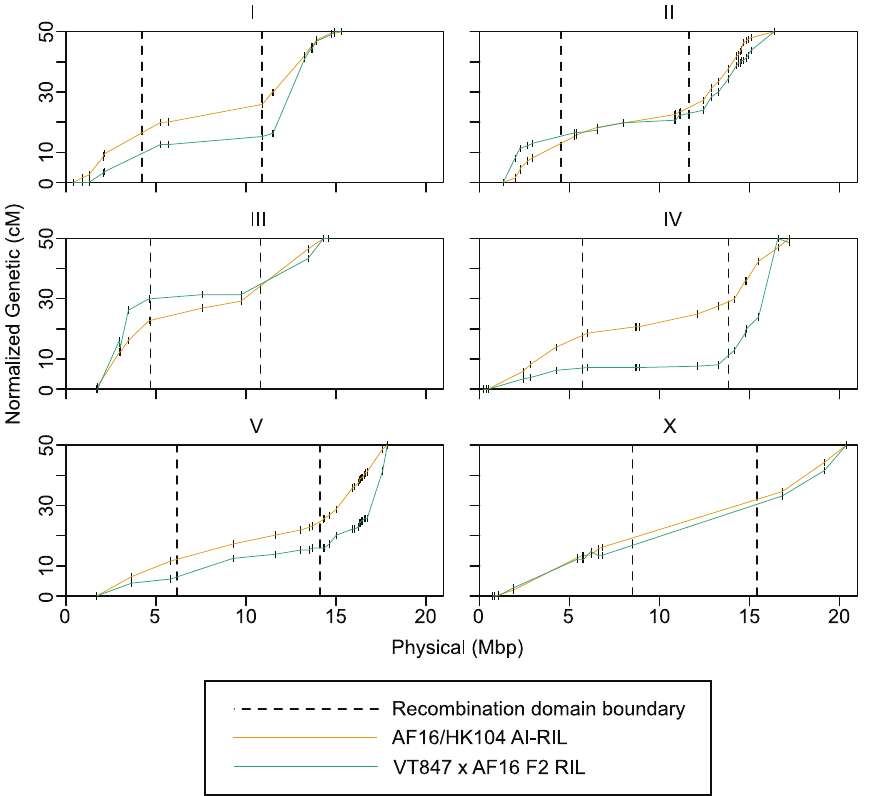
Figure 4. Intra-species recombination rate comparison. The Marey maps for the AF16/HK104 AI-RIL and the VT847 6 AF16 F2 RIL are provided for one chromosome per panel. Only markers successfully typed in both RIL sets are plotted, shown as short vertical lines. The map positions of these markers were normalized to produce 50 cM maps. Vertical dashed lines indicate the positions of recombination domain boundaries defined by the AI-RIL genetic map. Line segments with negative slopes (A arm domains of ChrIII and ChrX and B arm terminus of ChrIV) are blocks of markers with inverted genetic order in the AI-RIL and F2 RIL (Table S2).